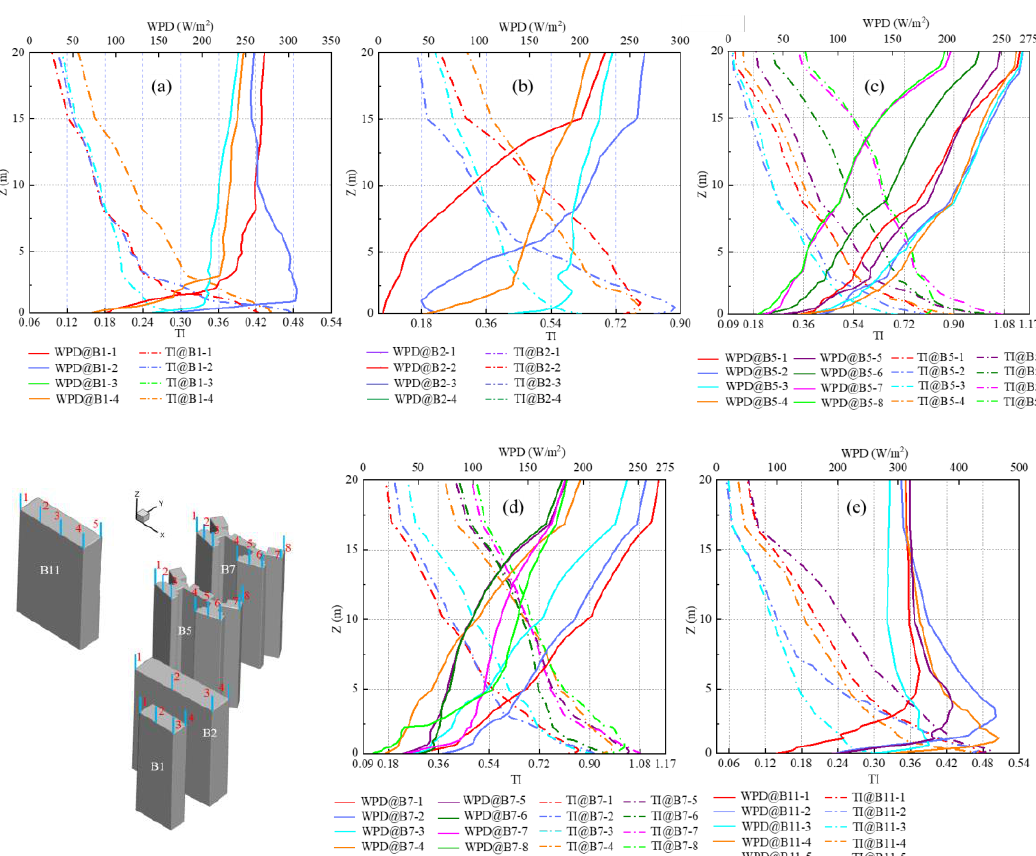
Figure 11. Simulated WPD and TI profiles at various roof locations.